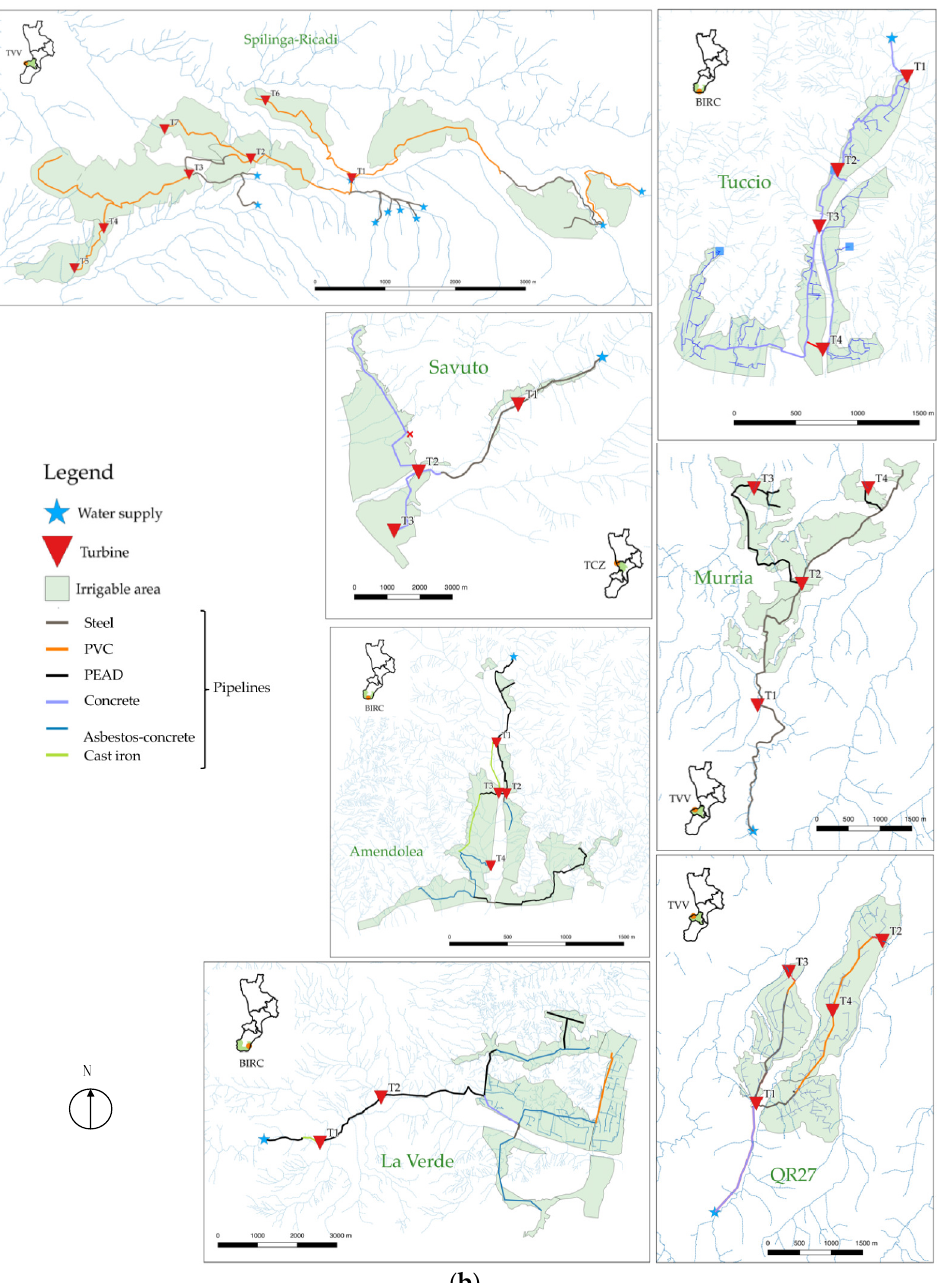
Figure 2. Location ( a ) and layout ( b ) of the seven investigated irrigation systems in three water user associations of Calabria (Southern Italy). associations of Calabria (Southern